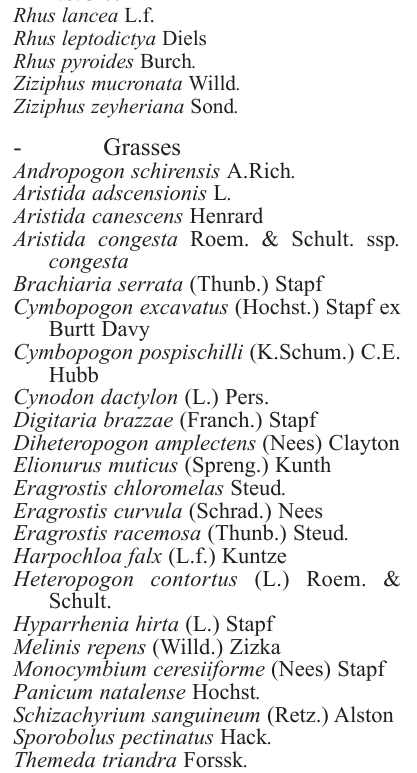
various grass species and a large variety of forbs (Louw 1970), representing a climax or close to climax condition. Grazing by cattle is often found in this vegetation type, but the dominance of sour grass species often results in a low nutrient status of the grass during winter (Kerfoot 1987; Bredenkamp & Van Rooyen 1996).